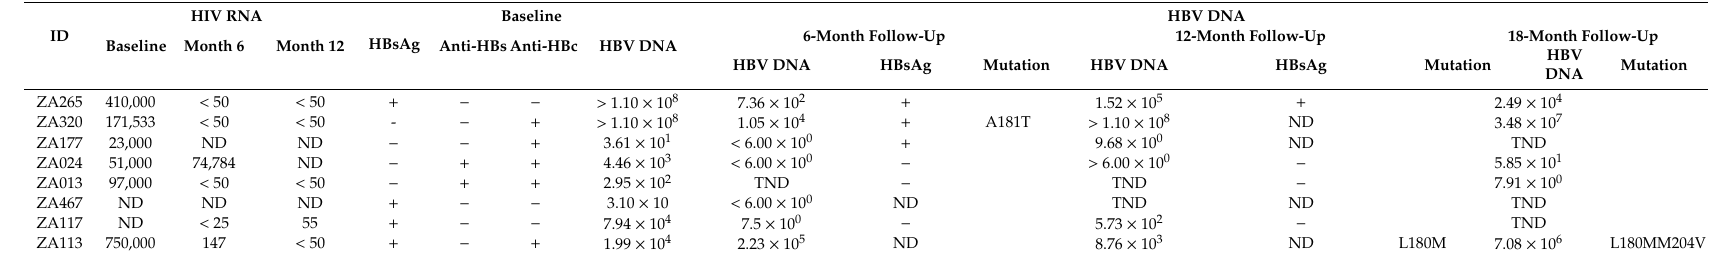
Table 4. HBV virologic response to lamivudine-based ART over 18 months of follow-up.